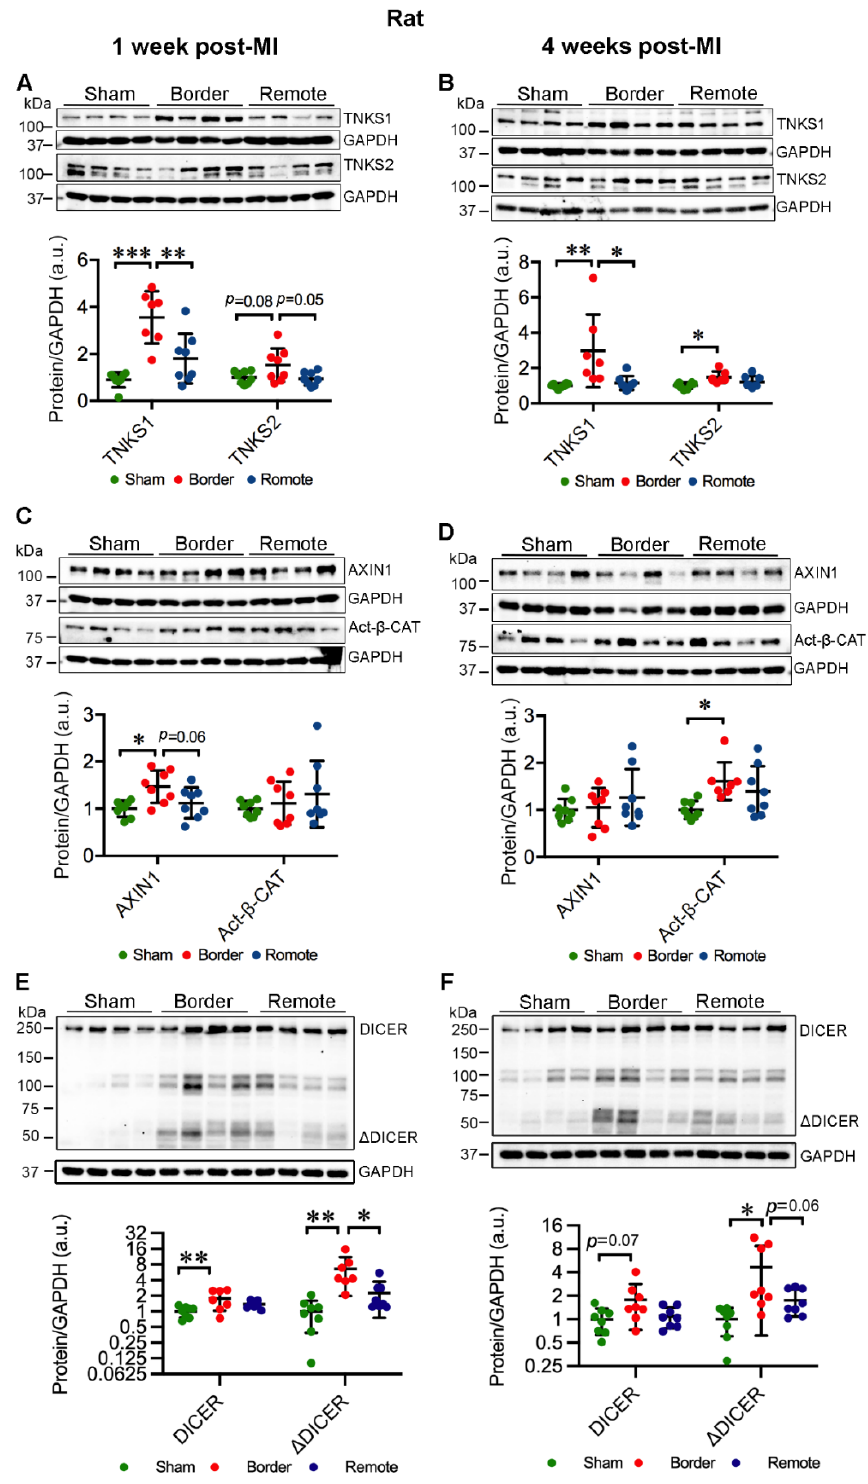
Figure 2. Ischemic injury augments TNKS1 and TNKS2 in the border area in rat hearts. ( A , B ) Rep- resentative immunoblots of TNKS1 and TNKS2 in the remote and border areas in MI rat hearts and sham-operated controls at 1 week ( A ) and 4 weeks ( B ) post-MI. ( A ) Sham: n = 8; MI Border: TNKS1, n = 7; TNKS2, n = 8; MI Remote: n = 8. ( B ) Sham: n = 8; MI Border: n = 7; MI Remote: n = 8. ( C , D ) Representative immunoblots of AXIN1 and Act- β -CAT in the remote and border areas in MI rat hearts and sham-operated controls at 1 week ( C ) and 4 weeks ( D ) post-MI. ( C ) Sham: n = 8; MI Border: n = 8; MI Remote: n = 8. ( D ) Sham: n = 8; MI Border: AXIN1, n = 8; Act- β -CAT, n = 7; MI Remote, n = 8. ( E , F ) Representative immunoblots of DICER and Δ DICER in the remote and border